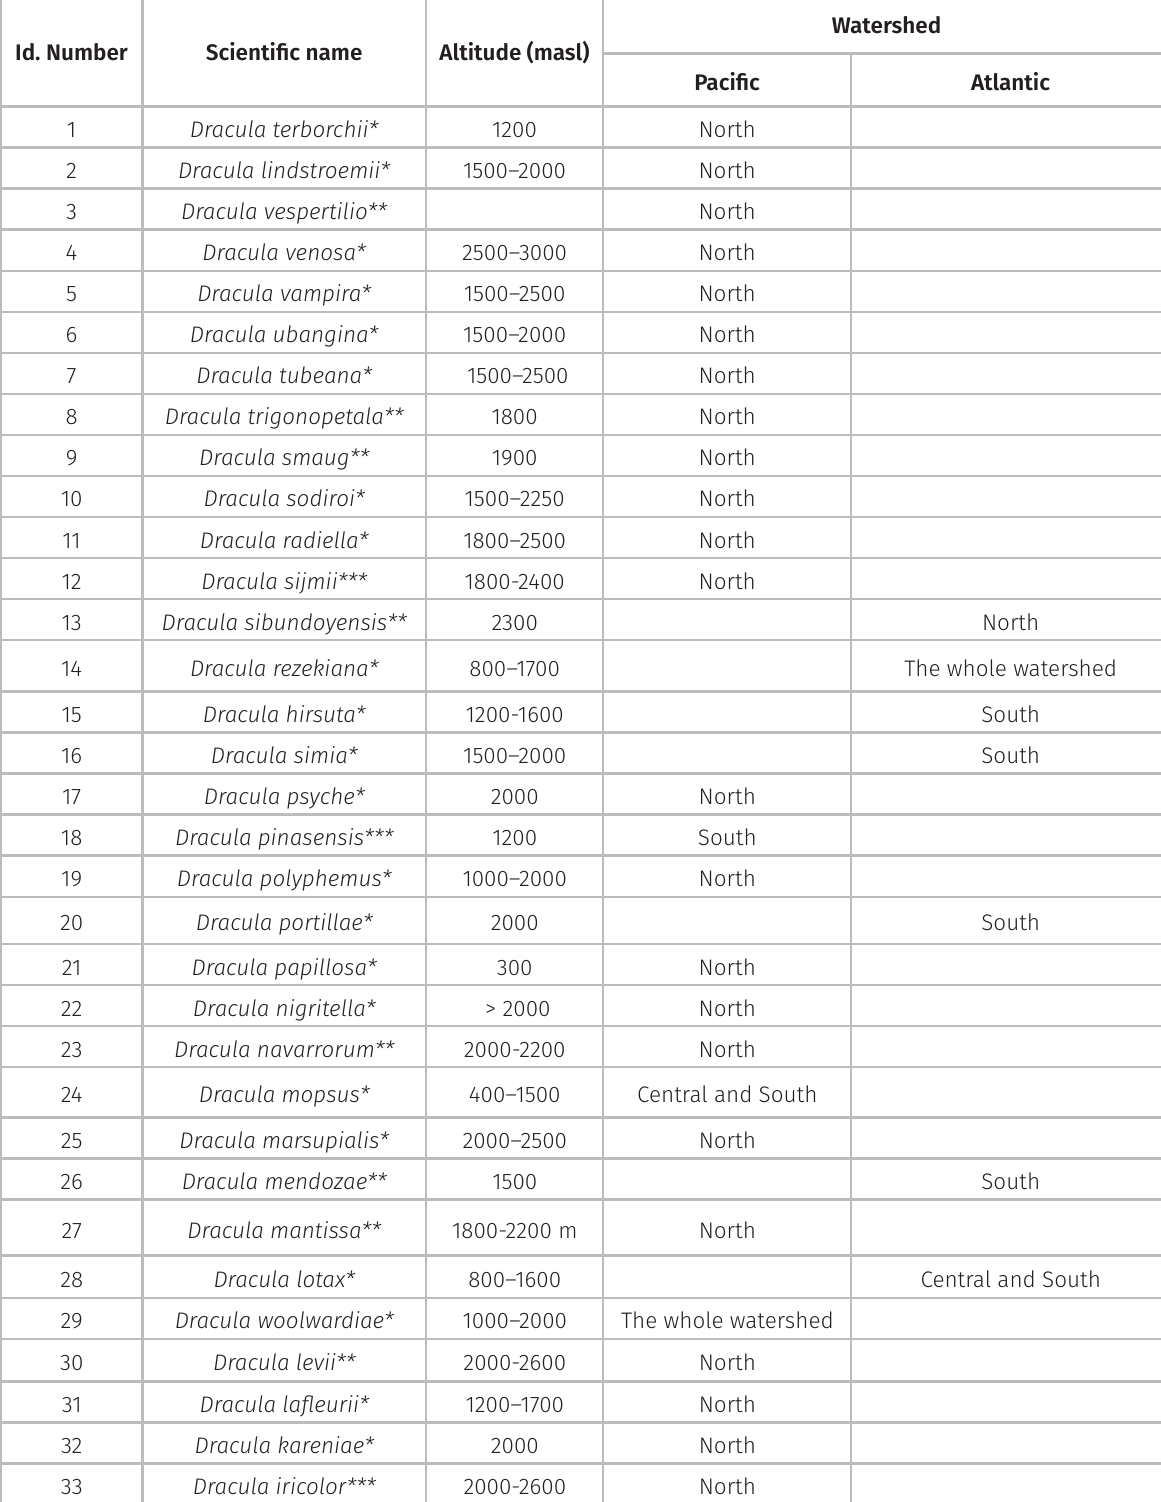
Table I. Altitude and watershed to which the species of the genus Dracula have been reported.